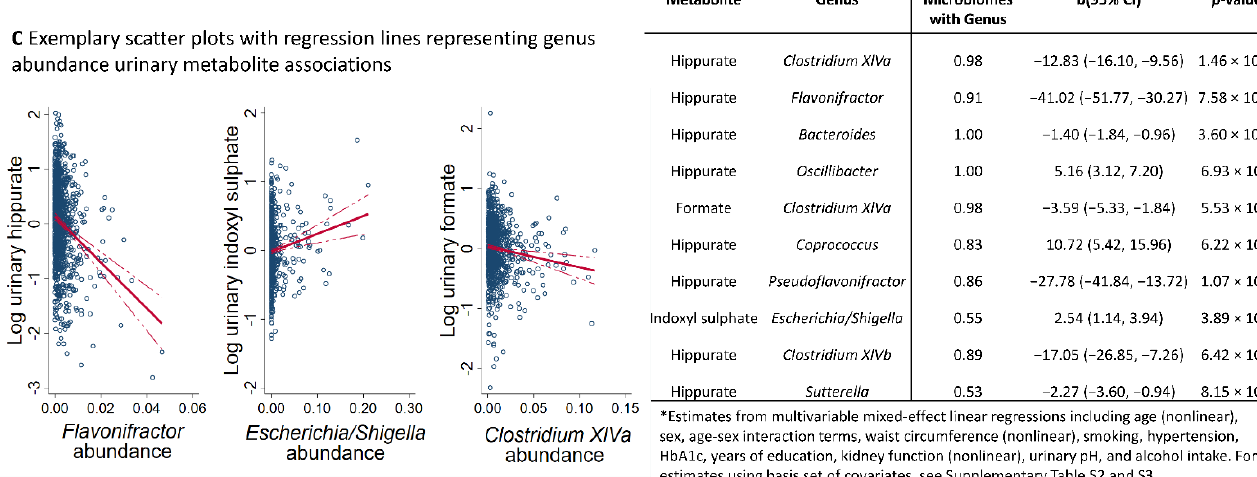
Figure 1. Overview of the significant metabolite–genus associations. ( A ) Boxplots for genus pres- ence metabolite association with a false discovery rate < 0.05. The Y-axis denotes the log-transformed and regression-normalised urinary concentrations. ( B ) Table displaying the genus presence metabo- lite associations with FDR < 0.05. ( C ) Scatter plots of selected genus abundances against urinary metabolite levels after log-transformation and regression-based normalisation. The red line indicates the linear regression line, where the dashed red lines display the 95% confidence interval. ( D ) Table displaying the genus abundance metabolite associations with FDR < 0.05. FDR—false discovery rate; b—unstandardised regression coefficients; 95% CI—95% confidence intervals.